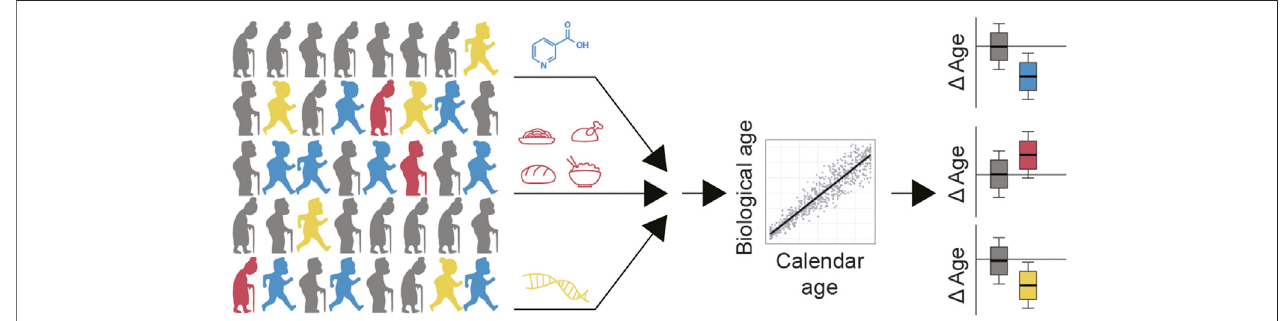
FIGURE 1 | Strategy for identifying candidate longevity interventions in humans. Population level data would ideally contain information on treatments that people take, e.g. supplementsand drugs, aswell as their nutrition patterns and genetics. Calculating biological age ofeach participant and comparing this to their calendar age wouldidentifywhichofthesefactorspotentiallyslowaging(e.g.blueandyellow)comparedtointerventionswhichmayaccelerateaging(e.g.red).Factorsthatslowaging (blue, yellow) or accelerate aging (red), may comprise nutrients, drugs, exercise routines, other lifestyle factors and/or combinations thereof. These would become candidate therapies to test in a prospective